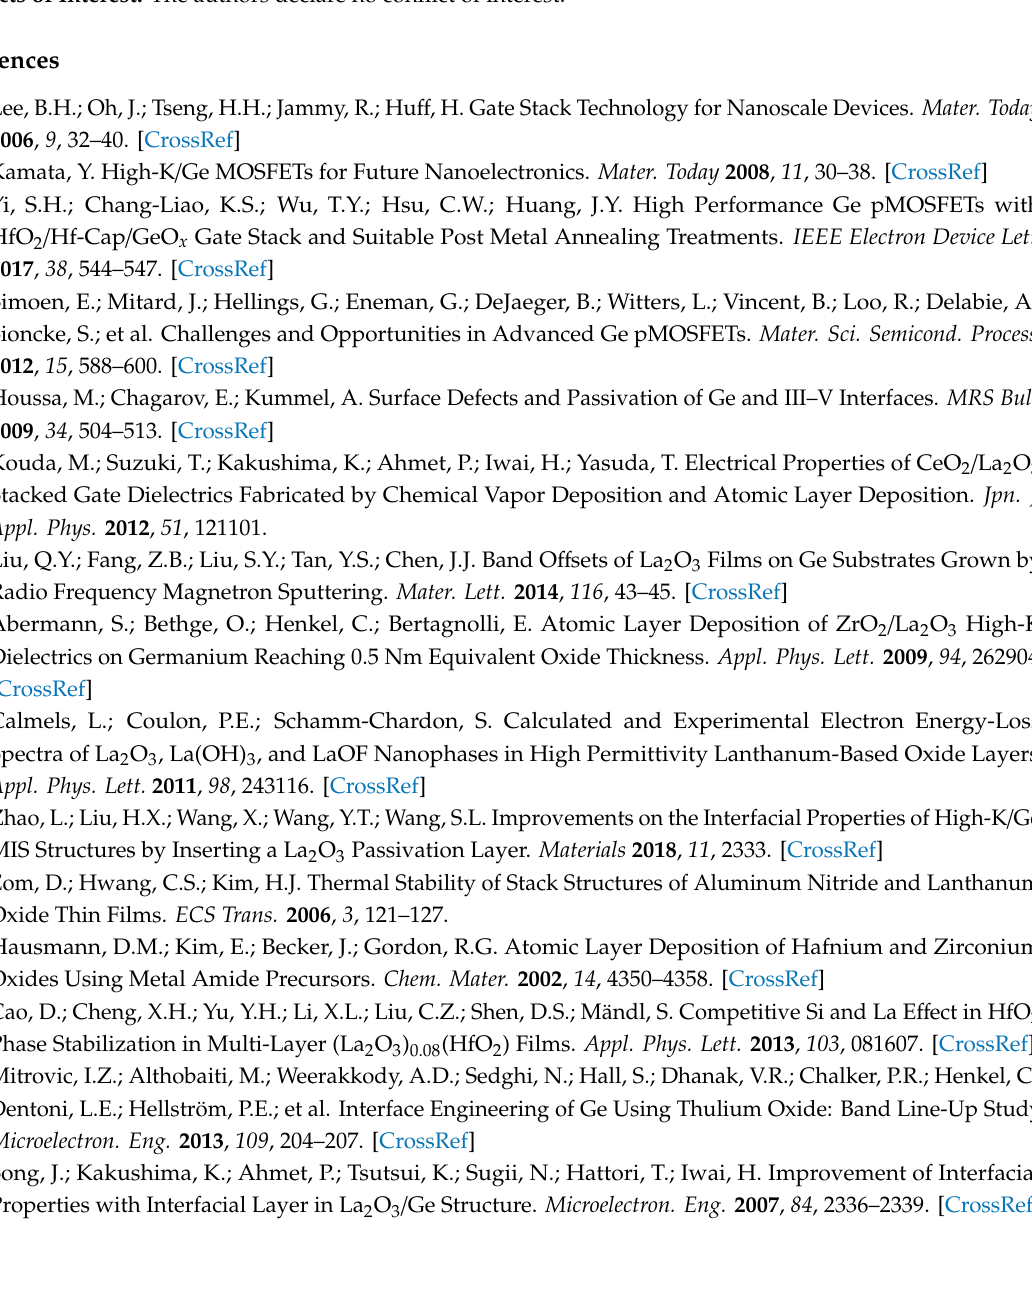
Table S1: Thickness of the deposited films (including interfacial layer) on Ge